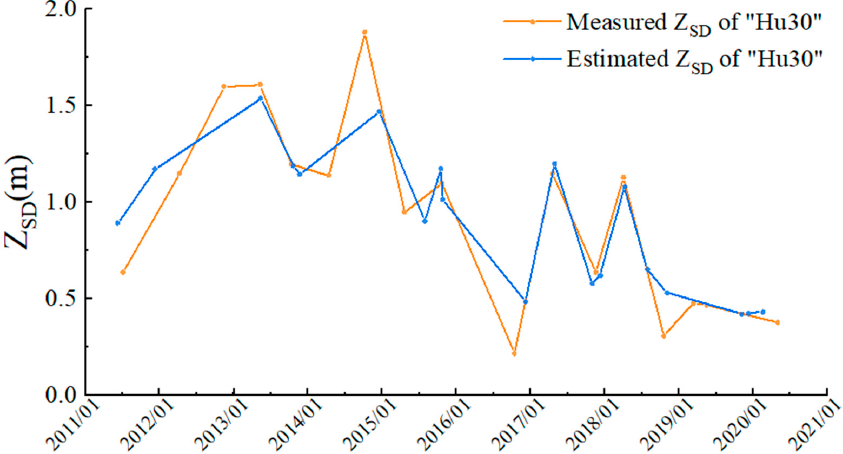
Figure 7. The Landsat-estimated Z SD and in situ-measured Z SD trend at sampling point Hu30.